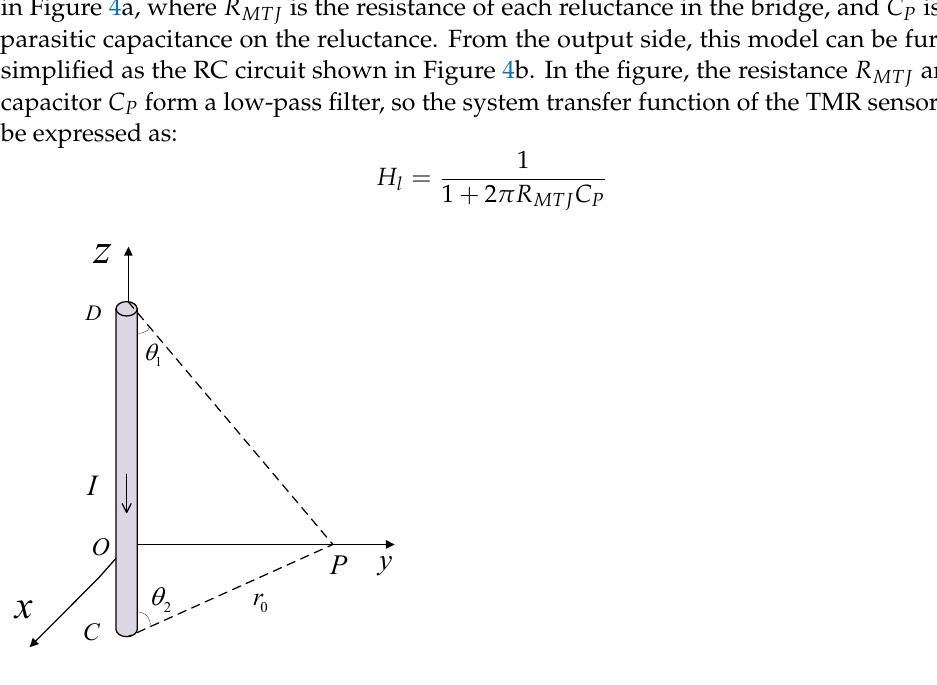
Figure 1. A schematic diagram of the magnetic field generated around a current-carrying wire.